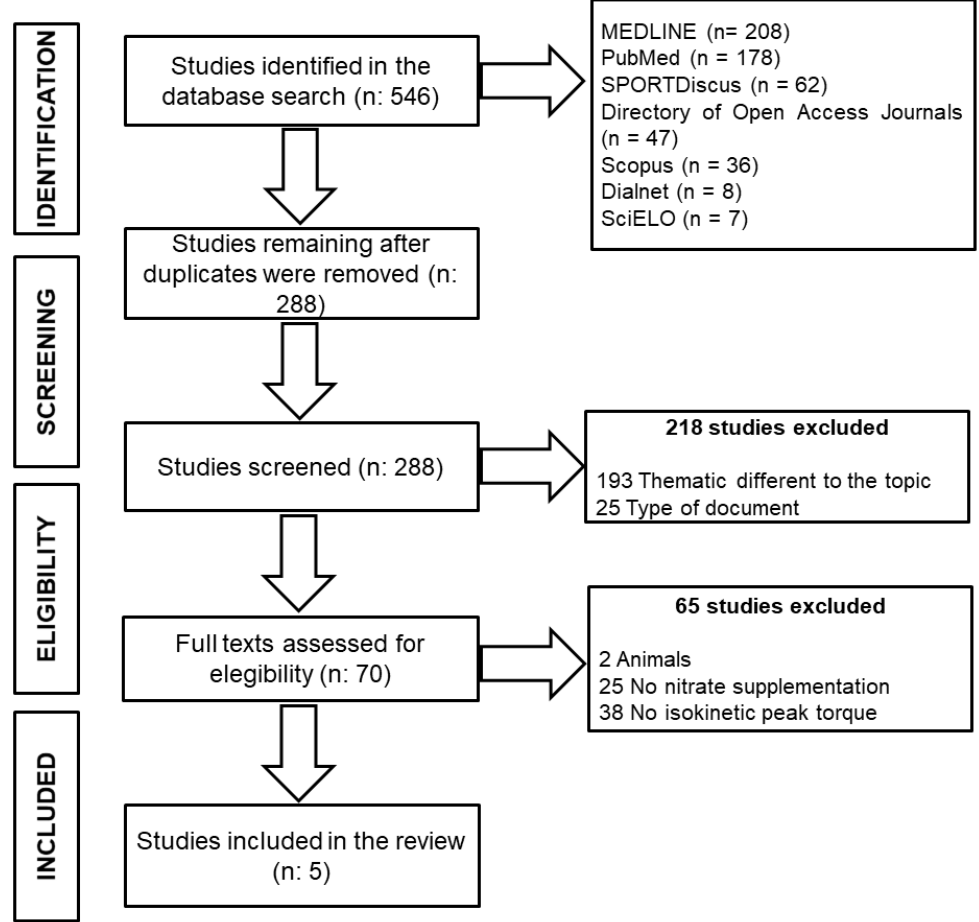
Figure 1. Preferred Reporting Items for Systematic Reviews and Meta-Analysis (PRISMA) flowchart.